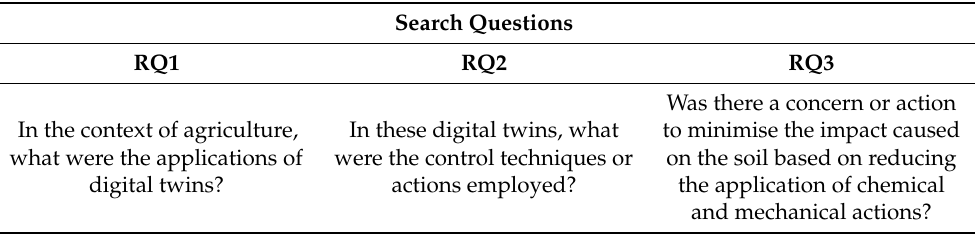
Table 1. Key phrases used in the database query. Questions.